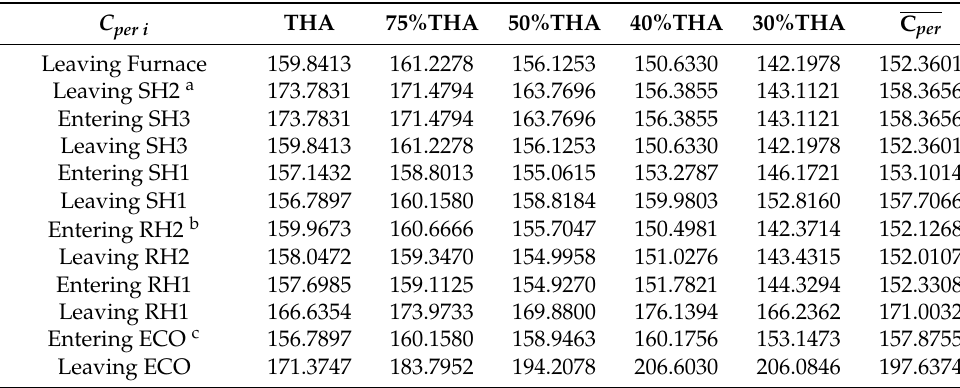
Table 9. The C per value at different positions and the average cost. C per